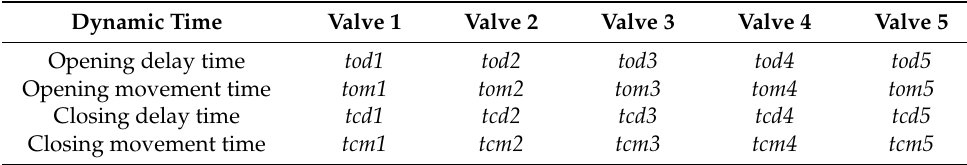
Table 1. Dynamic time of the digital